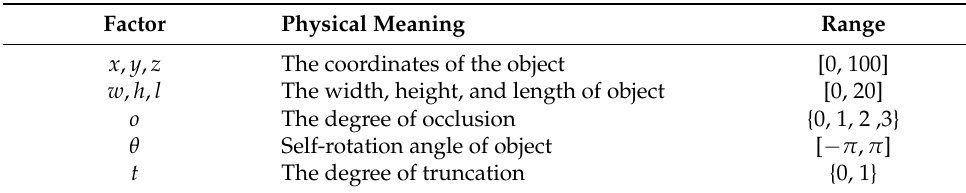
Table 1. The detail of input factors.